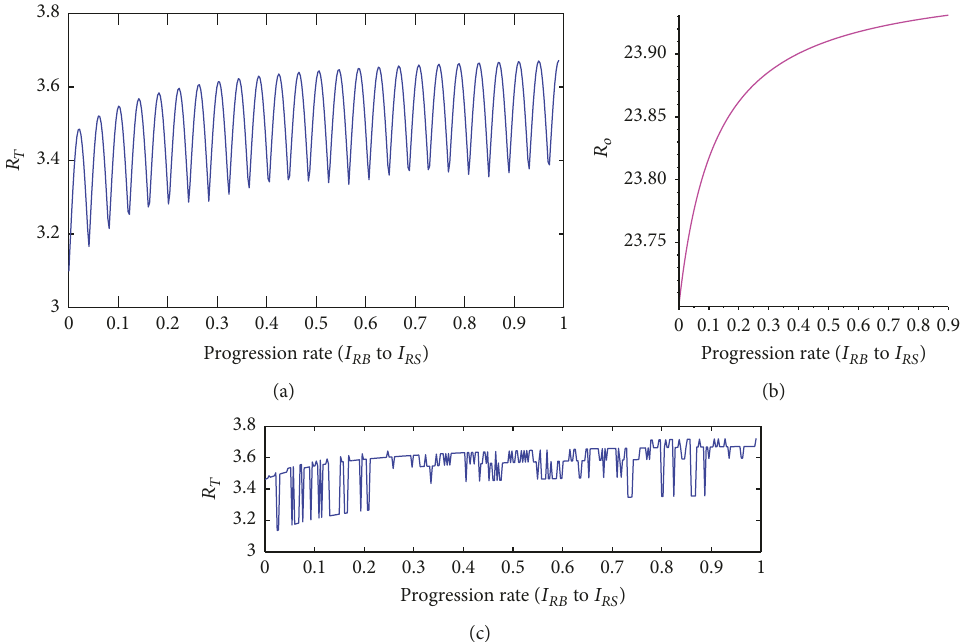
Figure 2: Effect of progression rates from 𝐼 𝑅𝐵 to 𝐼 𝑅𝑆 on the periodic reproduction